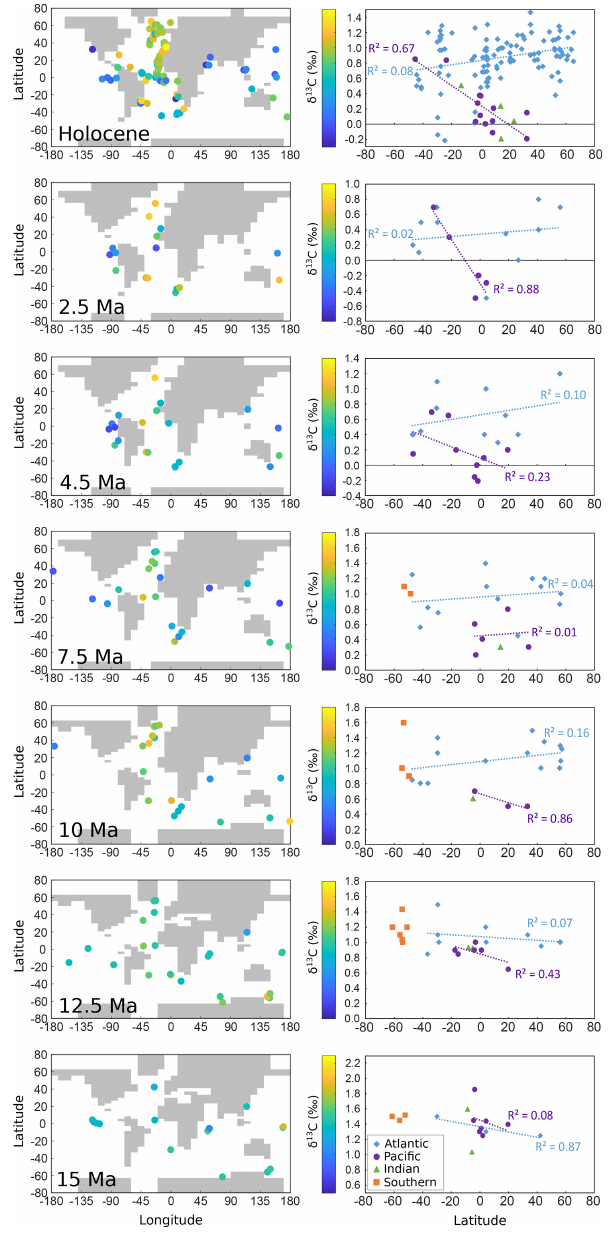
Figure 2. Benthic δ 13 C data and palaeo-locations overlaid on palaeo-coastlines (left column). Benthic δ 13 C data plotted by lat- itude for each time slice, showing the linear regression and R 2 for the Atlantic and Pacific basins (right column). The colour scale for the map is also the y axis scale for the per-latitude data, and all axes have a range of